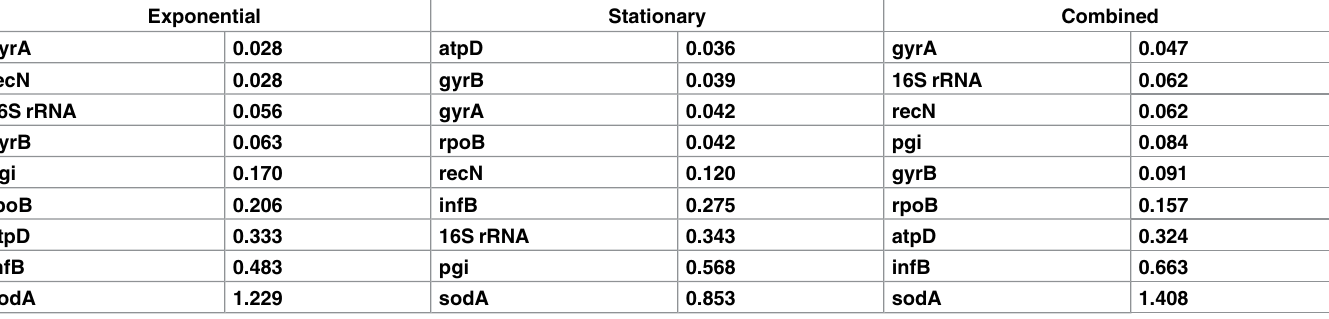
Table 5. Gene expressionstability rankings for different growth phase in A . paragallinarum serovarA analyzed by NormFinder. Exponential